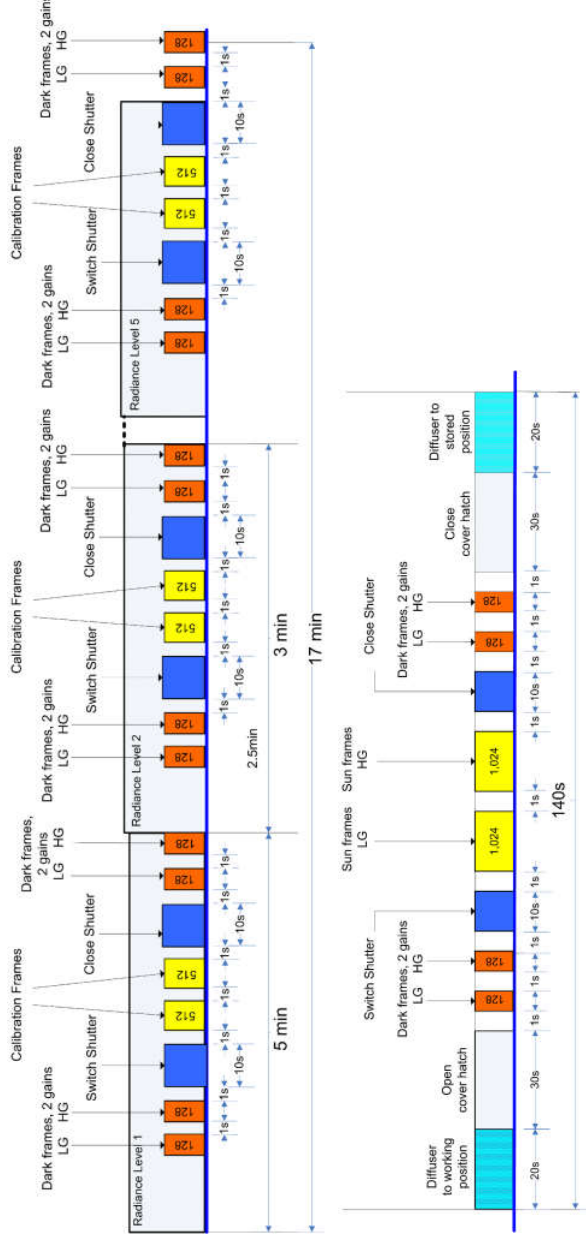
Figure 3. Characterization of integrating sphere for part of VNIR (top) and SWIR (middle) at different illumination levels (bottom). (Image by PTB, OHB System